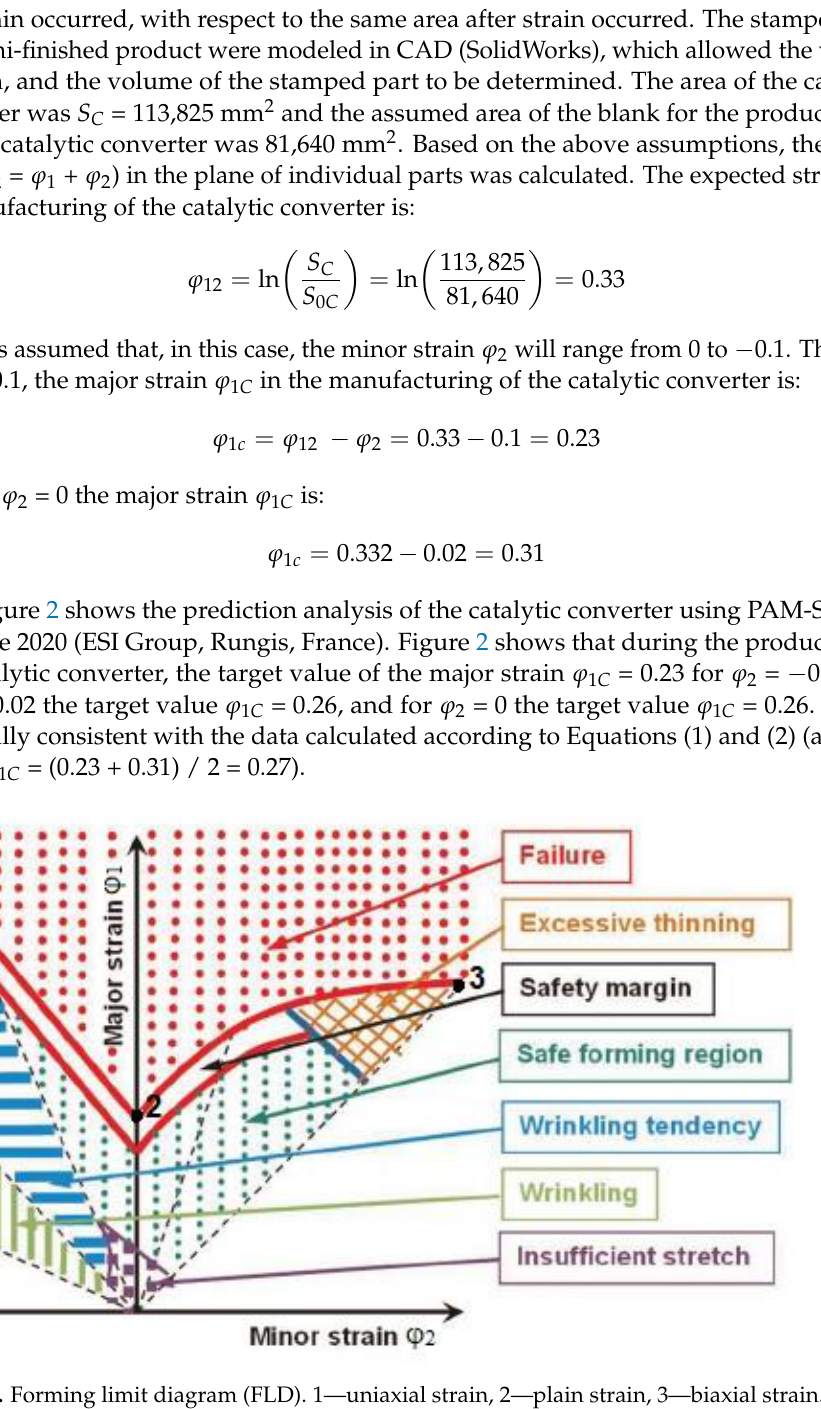
Figure 1. Forming limit diagram (FLD). 1 — uniaxial strain, 2 — plain strain, 3 — biaxial strain.